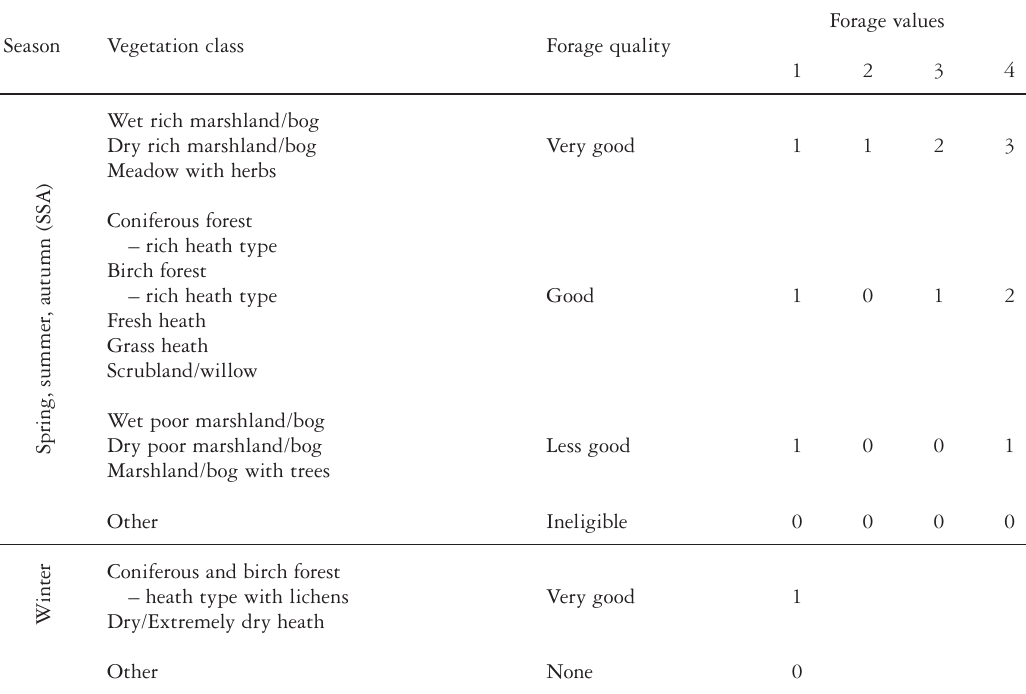
Table 1. Vegetative classification and forage quality classification according to REN2000 (County Administration Boards 2000). Forage values are alternative weightings of vegetation types in the